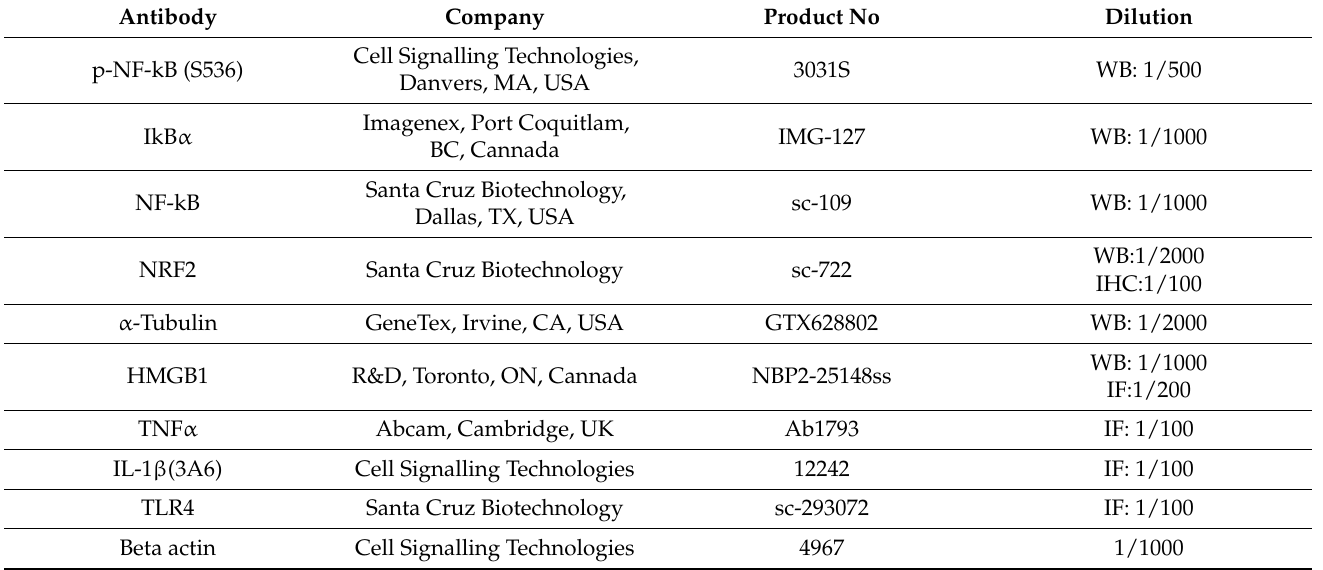
Table 2. Details of primary